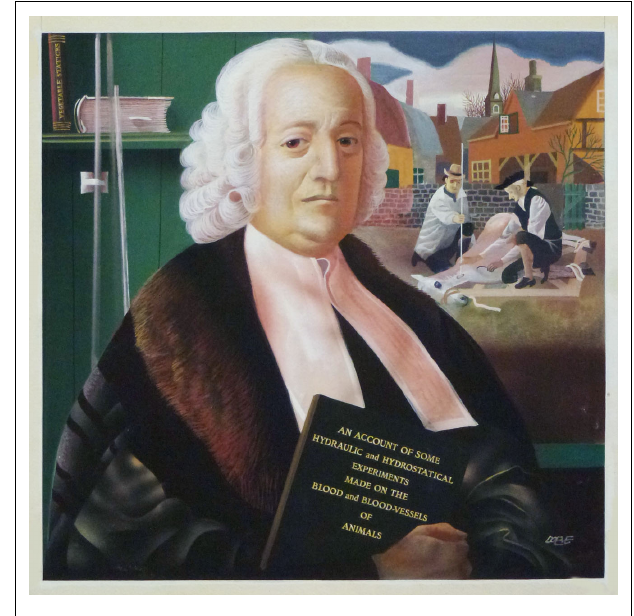
FIGURE 5 | Portrait of Rev. Stephen Hales (1677–1761). He was the first to report periodic fluctuations in arterial pressure and the beat-to-beat interval that varied with respiration.These pioneering studies were performed on conscious horse. Source: Reproduced with permission from the John P. McGovern Historical Collections and Research Center; Houston Academy of Medicine-Texas Medical Center Library; Houston,TX, USA. P-261, color photo; Artist: Joseph F. Doeve, painted in